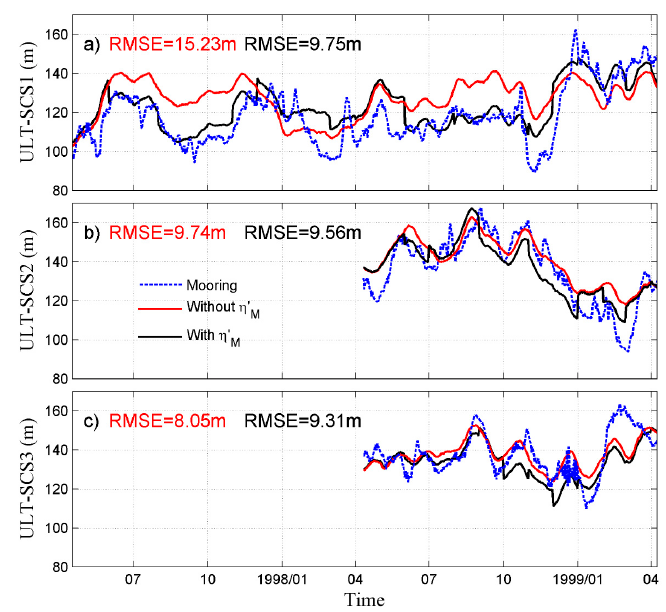
Figure 10. ( a – c ) Time series of buoy-data-derived ULT (blue dashed line), altimeter-derived ULT without η (cid:48) (red solid line) and with η (cid:48) (black solid line). The locations of three ATLAS buoys are marked in Figure 1.